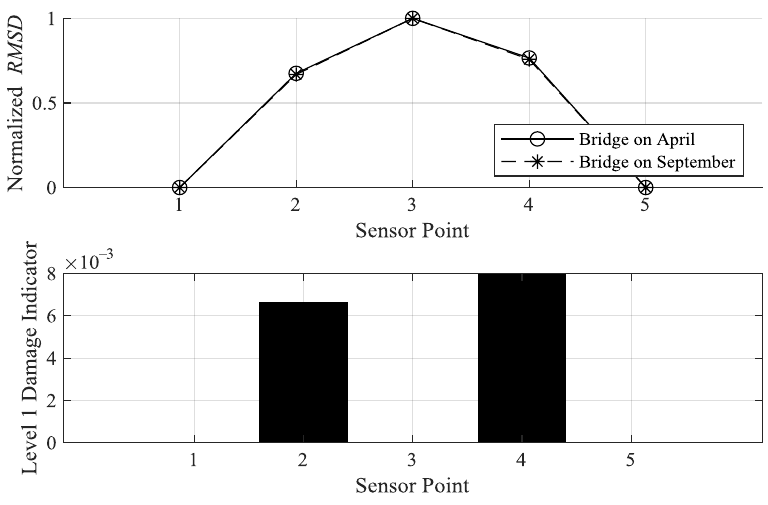
Figure 31. Level 1 damage indicator of Wenzhou bridge in September.